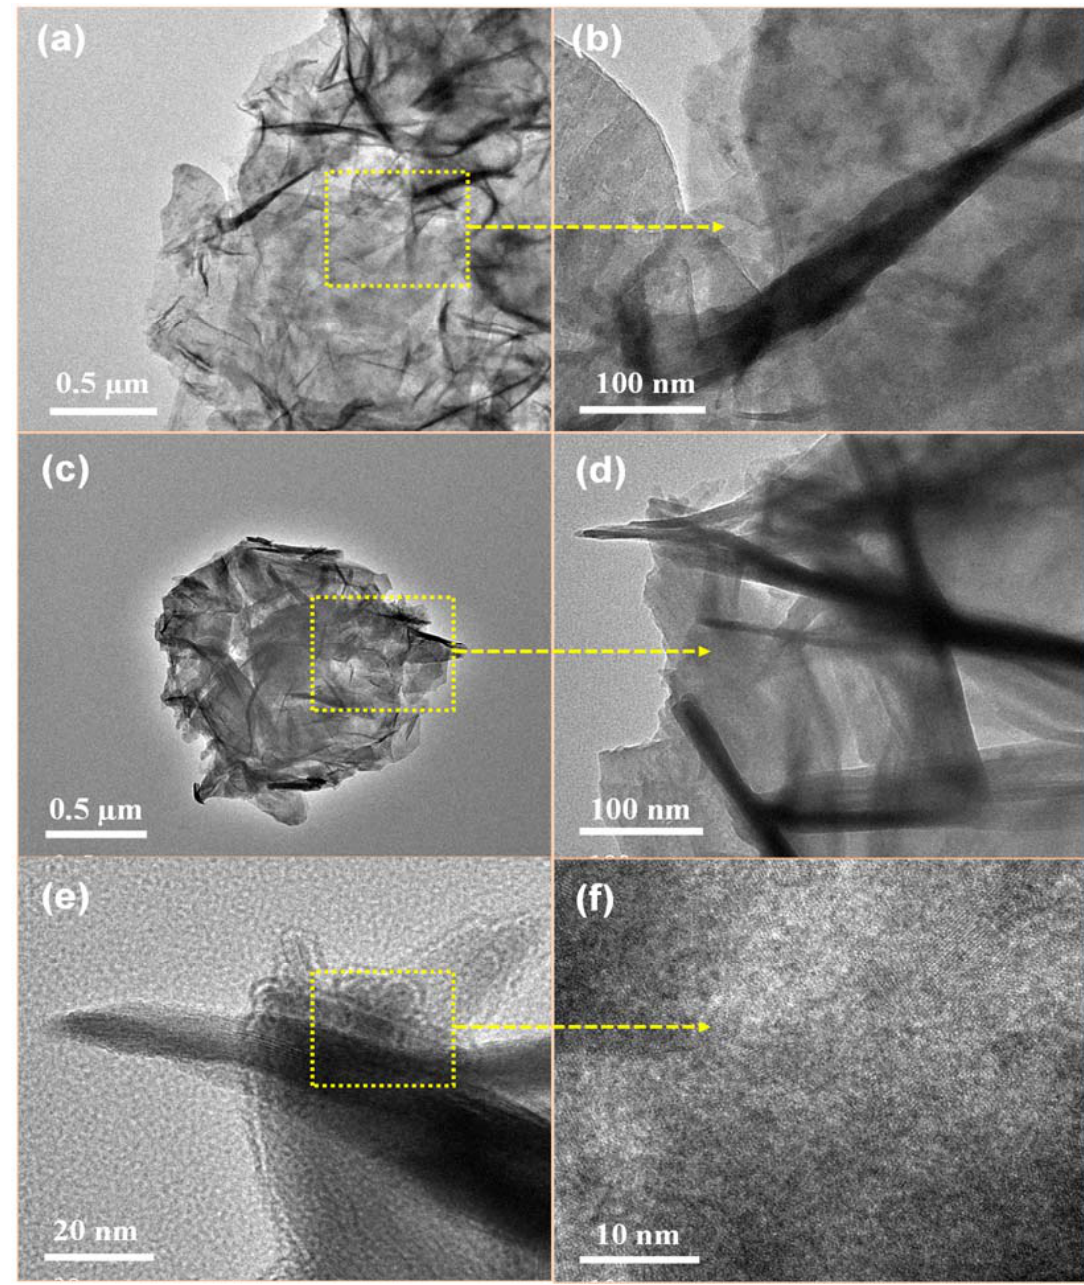
Figure 3. ( a , b ) TEM images of NiO, and ( c – f ) TEM and HRTEM images of NiZn 2 O 4 @3D ‐ NF at different magnifications.